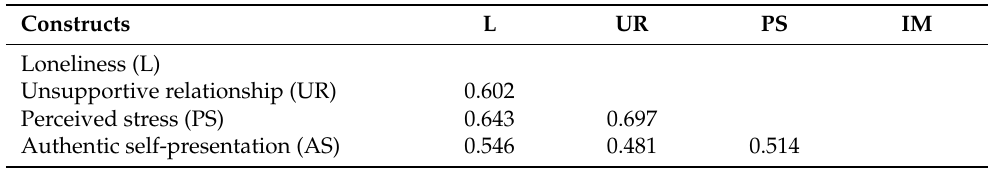
Table 3. Discriminant validity (HTMT) ( n =